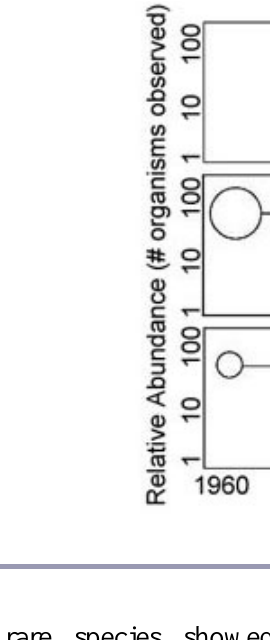
Fig. 3. Relative abundance and distribution of the Ornamental organisms’ social-ecological guild, including the general class (a), and the special cases of butterflyfishes, Chaetodontidae (b) and rare species